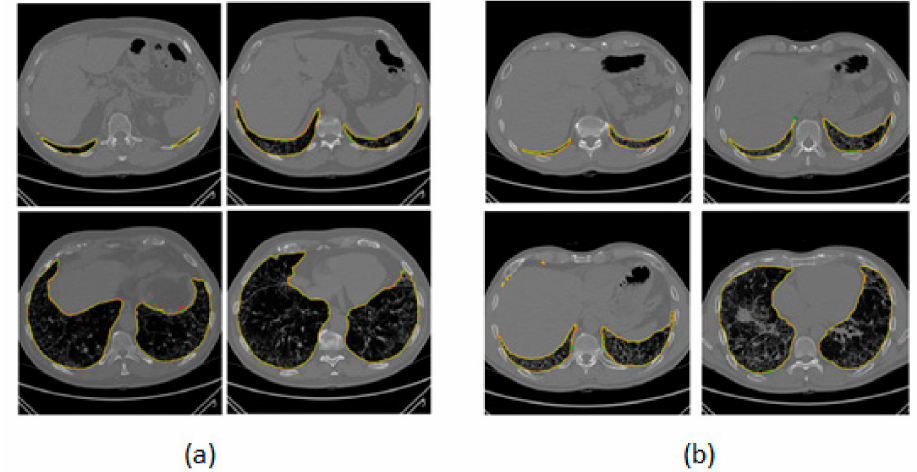
Figure 1. Two examples of lung segmentations (4 slices for both ( a ,( b ) high-resolution computed tomography (HRCT) studies). The manual segmentation (yellow), E-Net (red), and U-Net (green) are superimposed in both ( a , b ) images.